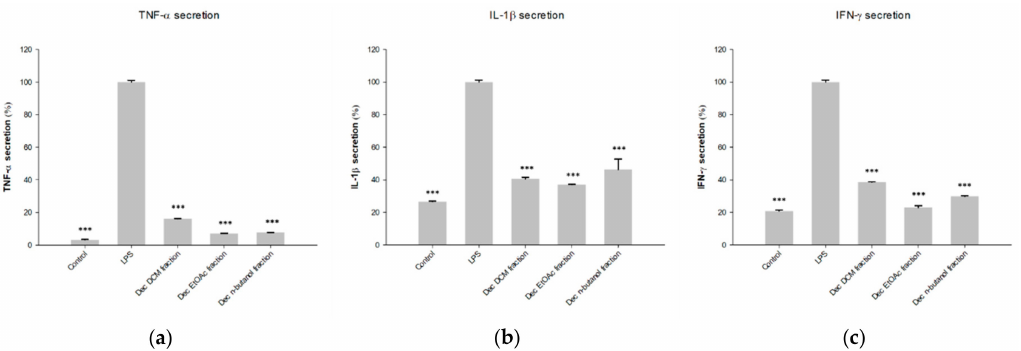
Figure 1. Inhibitory e ff ects of the LLE fractions of the decoction of HQJZT on production of ( a ) TNF- α ; ( b ) IL-1 β and ( c ) IFN- γ ; concentration of the extracts: 25 µ g / mL; n = 3; mean (SD); Control: unstimulated cells; LPS: LPS-stimulated cells (1 µ g / mL) without treatment; * ( p < 0.05); ** ( p < 0.01); *** ( p < 0.005); significant di ff erences obtained by ANOVA with Dunnett-T